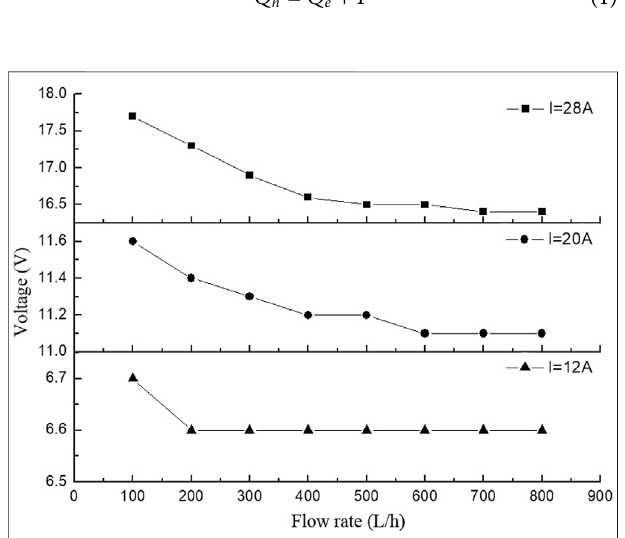
FIGURE7| Variationtendencyoftheworkingvoltagewiththecirculating water fl ow rates.